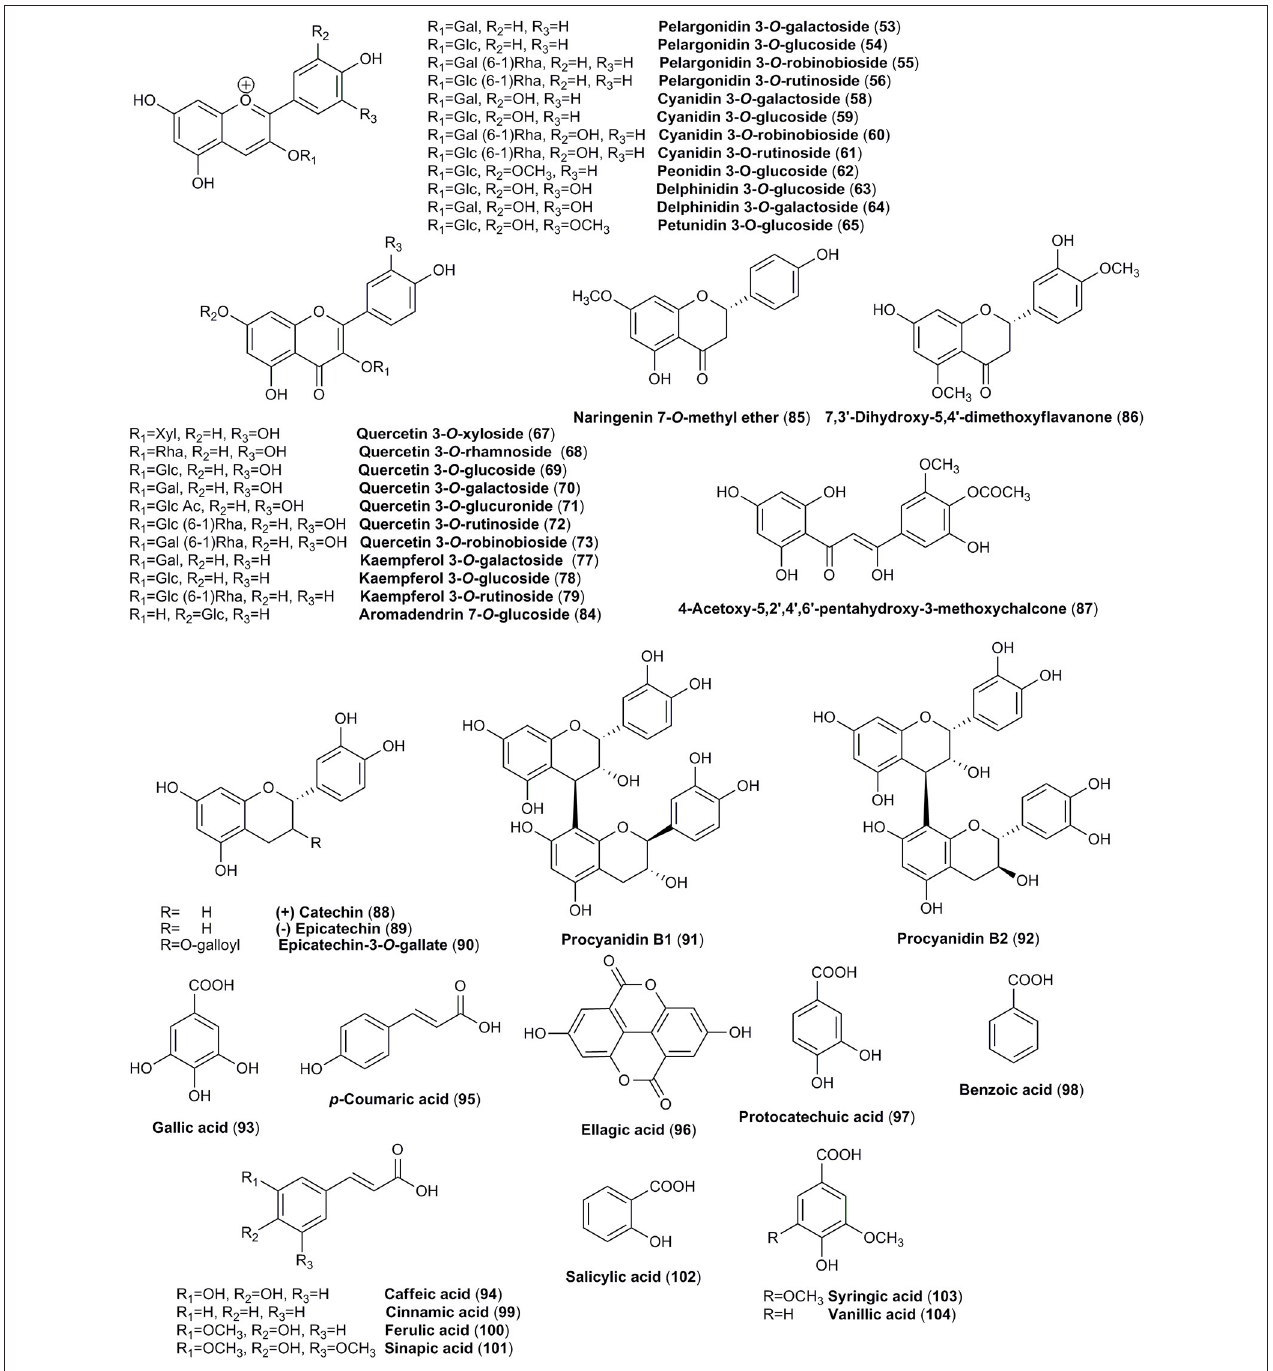
FIGURE 3 | The chemical structures of anthocyanins, flavonoids, and phenolic acids identified in fruits of C. mas and/or C. officinalis . et al., 2015), HPLC (Tural and Koca, 2008; Capanoglu et al., 2011) and LC-PDA-MS (Pawlowska et al., 2010). In some cultivars of the southeastern Europe peonidin 3- O -glucoside ( 62 ) followed by cyanidin 3- O -galactoside ( 58 ) was established as the major constituent of C. mas fruits (Drkenda et al., 2014).